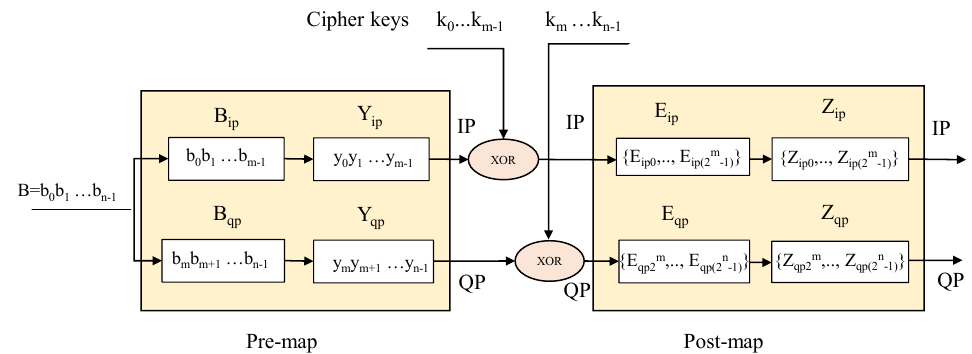
Figure 4. The detailed operation of the JEM method.